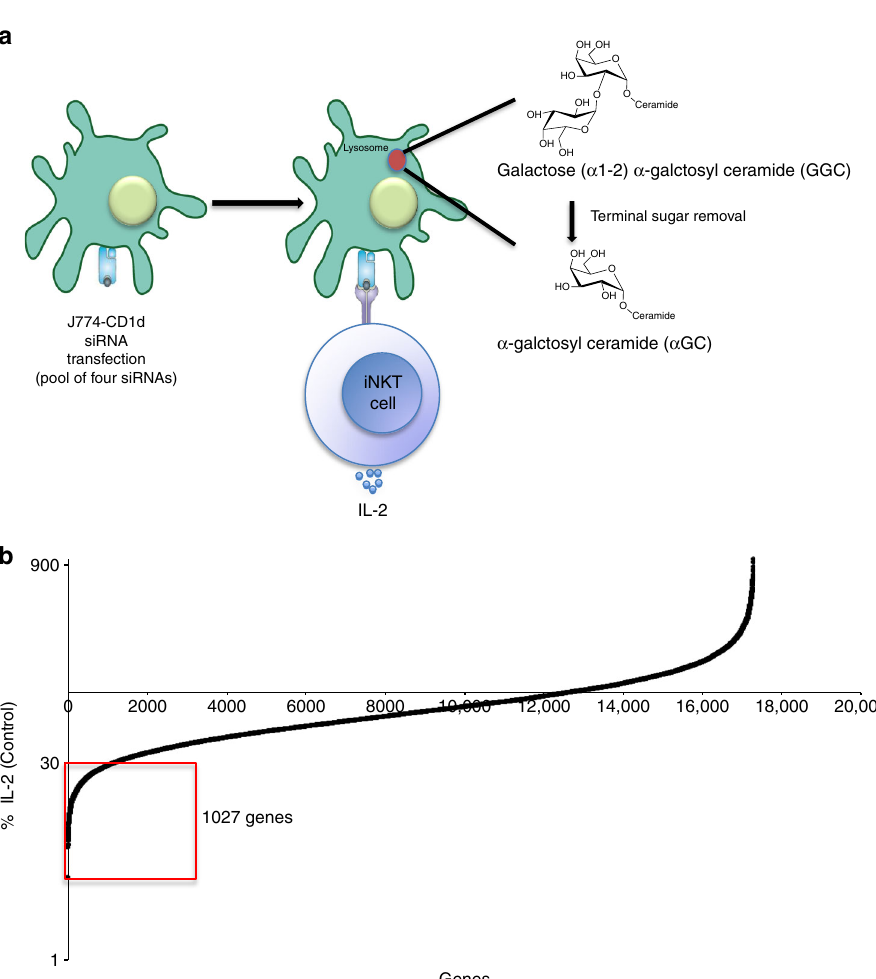
Fig. 1 Data analysis of the siRNA screen. a Schematic outline of the assay. J774-CD1d cells were transfected with siRNA pools, 36 h later these cells were loaded with GalGalCer for 6 h before culture with an iNKT cell hybridoma. Sixteen hours later supernatant was used to perform IL-2 Alpahlisa. b Plots IL-2 release stimulated by APCs transfected with each of the 17,660 siRNAs in the library ordered by percentage of control (Log). Genes showing >70% decrease in IL-2 (average of two wells) as compared to the control (red box) were considered for further analysis. See also Supplementary Fig.